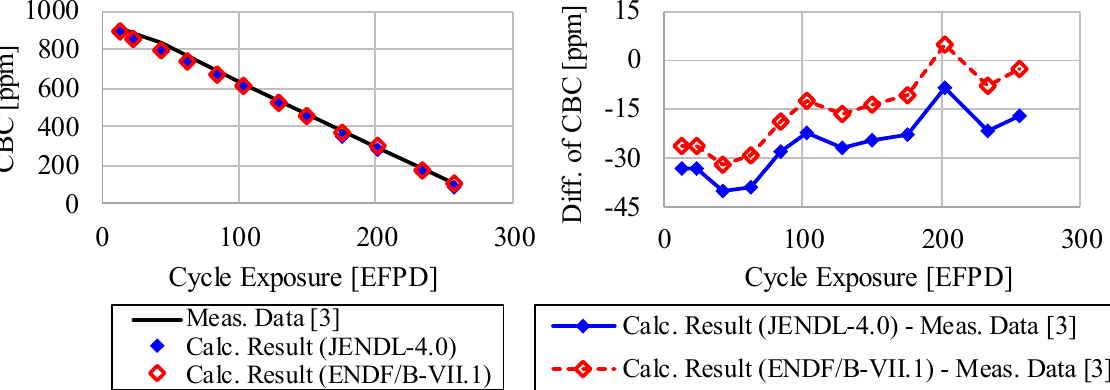
Figure 7. Boron Letdown Results of Cycle 2.